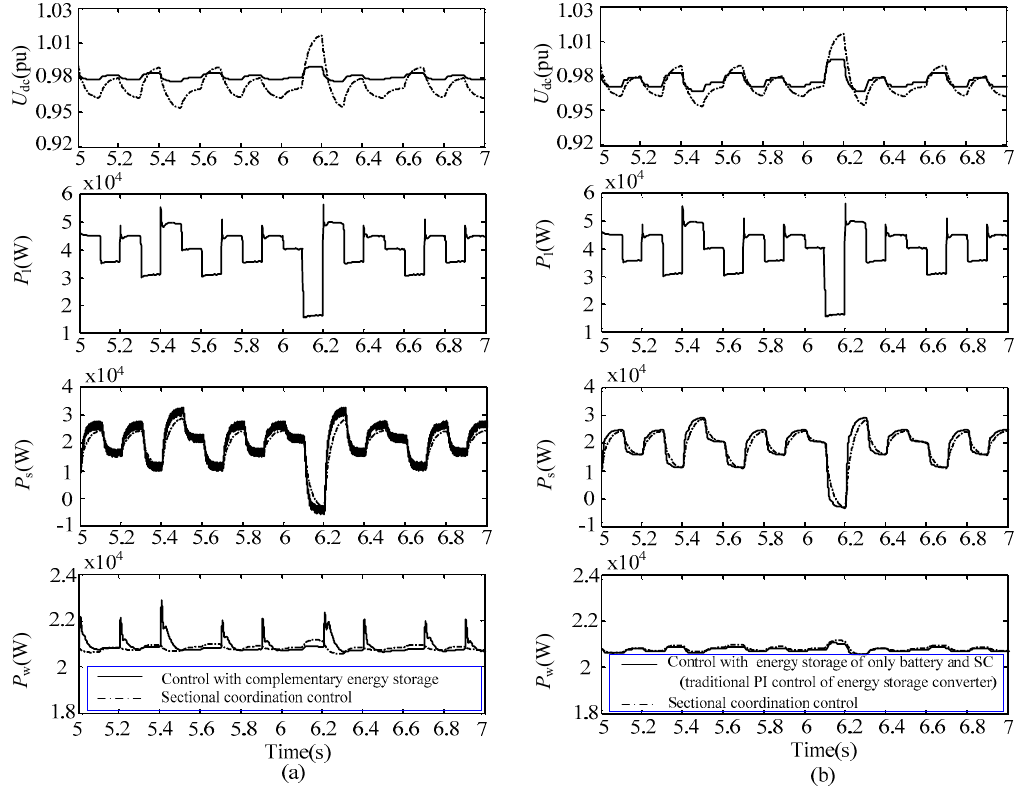
Figure 14. Performance of each unit in the DC microgrid with fluctuating load: ( a ) The solid lines were obtained by using the improved method of hybrid complementary energy storage based on prediction and the dotted lines were obtained utilizing the basic coordinated control; ( b ) The solid lines were obtained by using the improved method based on PI control and the dotted lines were obtained utilizing the basic coordinated control.